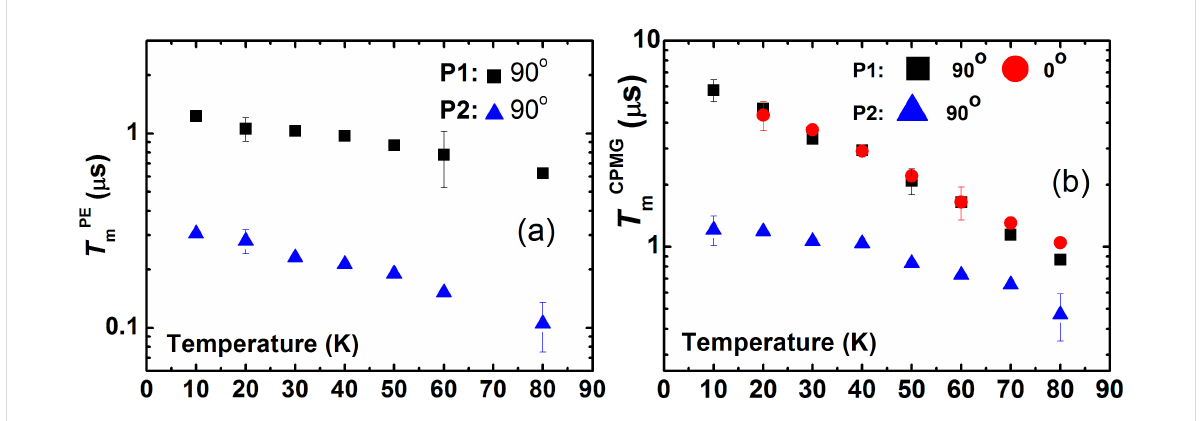
Figure 4: Temperature dependence of the phase relaxation time T m of P1 and P2 at a frequency ν = 9.85 GHz measured with the primary echo se- quence for the 90° field orientation (a) and with the CPMG pulse sequence for 0° and 90° orientations of the magnetic field (b).